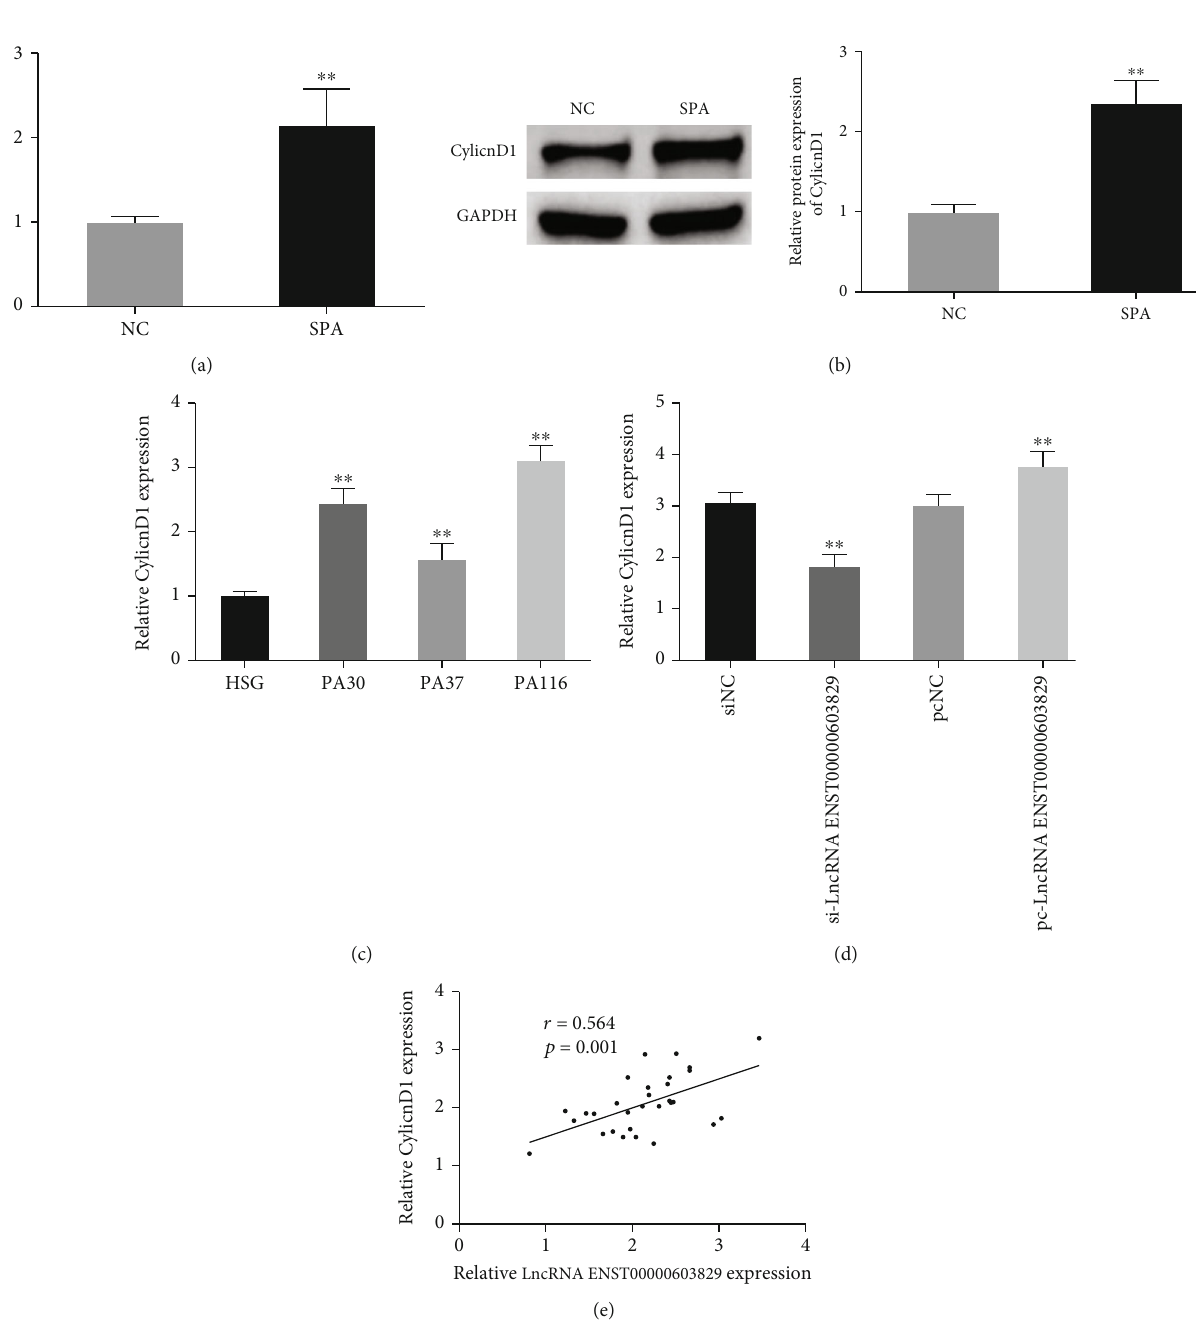
Figure 3: E ff ect of lncRNA ENST00000603829 on cyclin D1 expression. qRT-PCR assay for the cyclin D1 mRNA level in SPA tissues; (b) Western blot assay for cyclin D1 protein expression in SPA tissues, ∗∗ p < 0 : 01 vs. the NC group; (c) qRT-PCR assay for the cyclin D1 mRNA level in SPA cells, ∗∗ p < 0 : 01 vs. the HSG group; (d) qRT-PCR assay for cyclin D1 mRNA levels in cells after overexpression or knockdown lncRNA ENST00000603829, ∗∗ p < 0 : 01 vs. the siNC group, ∗∗ p < 0 : 01 vs. the pcNC group; (e) Pearson correlation analysis of the correlation between lncRNA ENST00000603829 and cyclin D1 expression in SPA